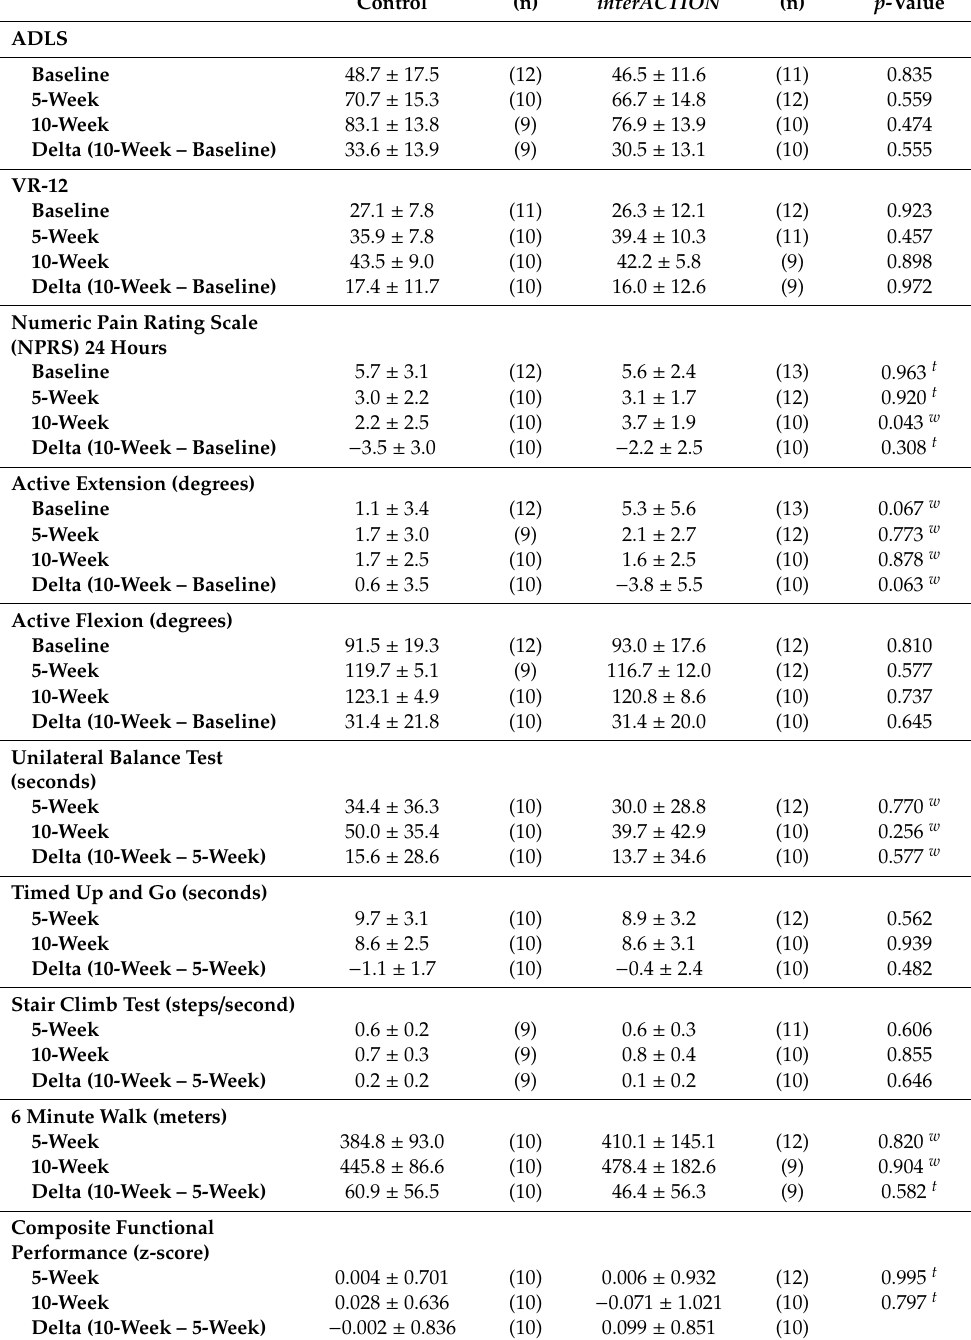
Table 4. Clinical and physical function outcomes over time in study arms ( t —two-sample t -test, w —Wilcoxon rank-sum test, *— p < 0.05). The sample size for each outcome is also provided (n), with any reduced sample size compared to Figure 2 indicating missing data. The functional performance outcomes were not measured at baseline because the timepoint was too close to